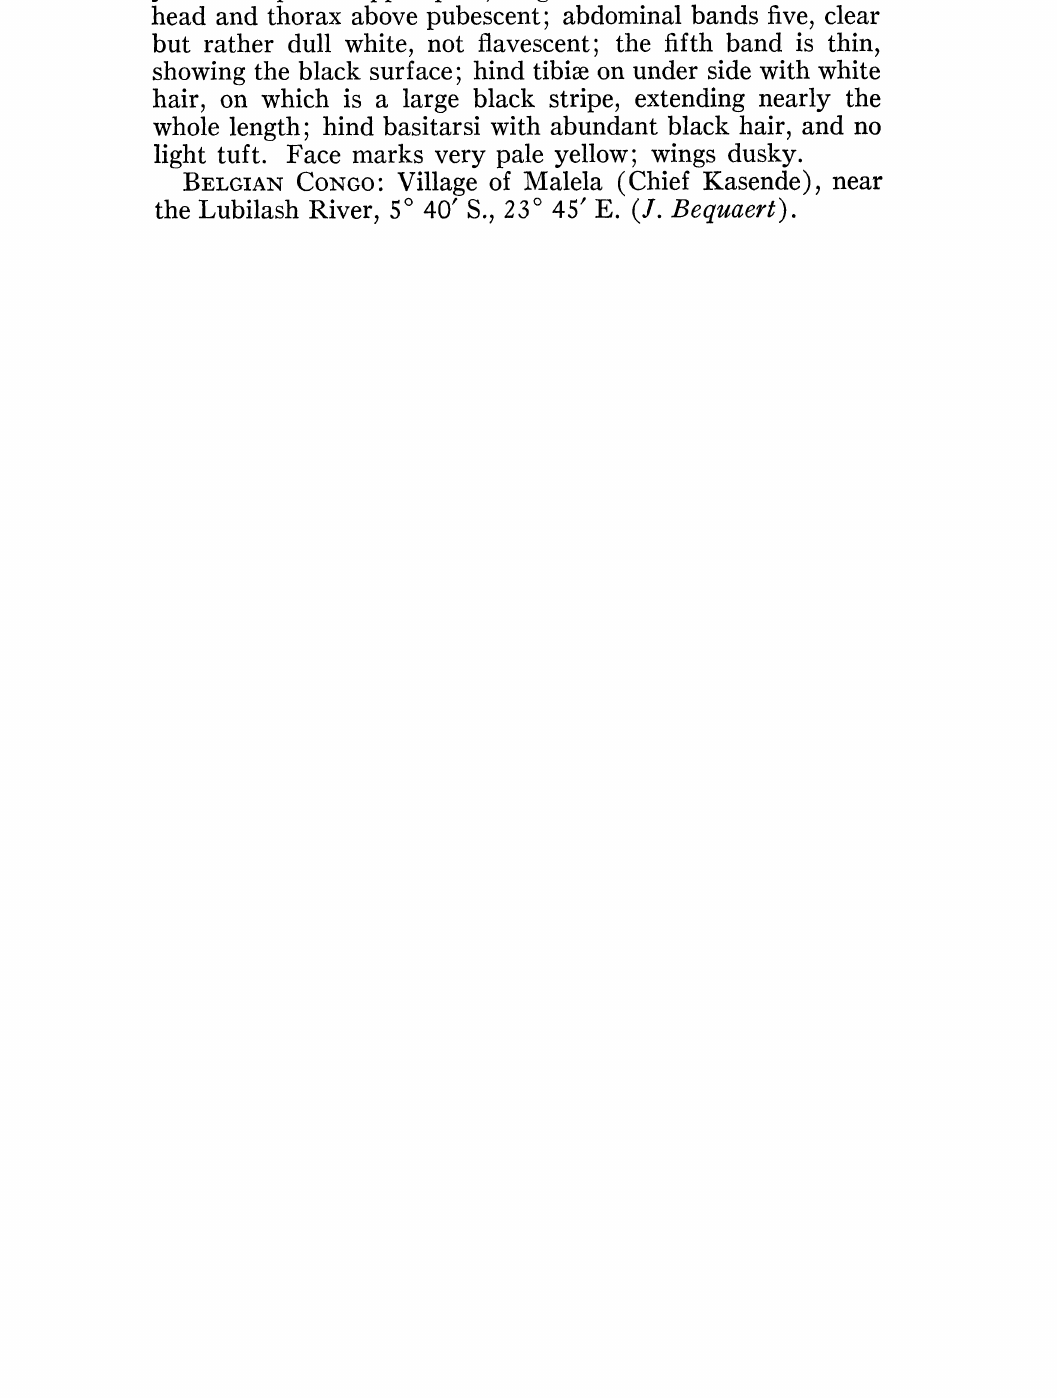
yellow stripe on upper part; flagellum red beneath. Hair of head and thorax above pubescent; abdominal bands five, clear but rather dull white, not flavescent; the fifth band is thin, showing the black surface; hind tibiae on under side with white hair, on which is a large black stripe, extending nearly the whole length; hind basitarsi with abundant black hair, and no light tuft. Face marks very pale yellow; wings